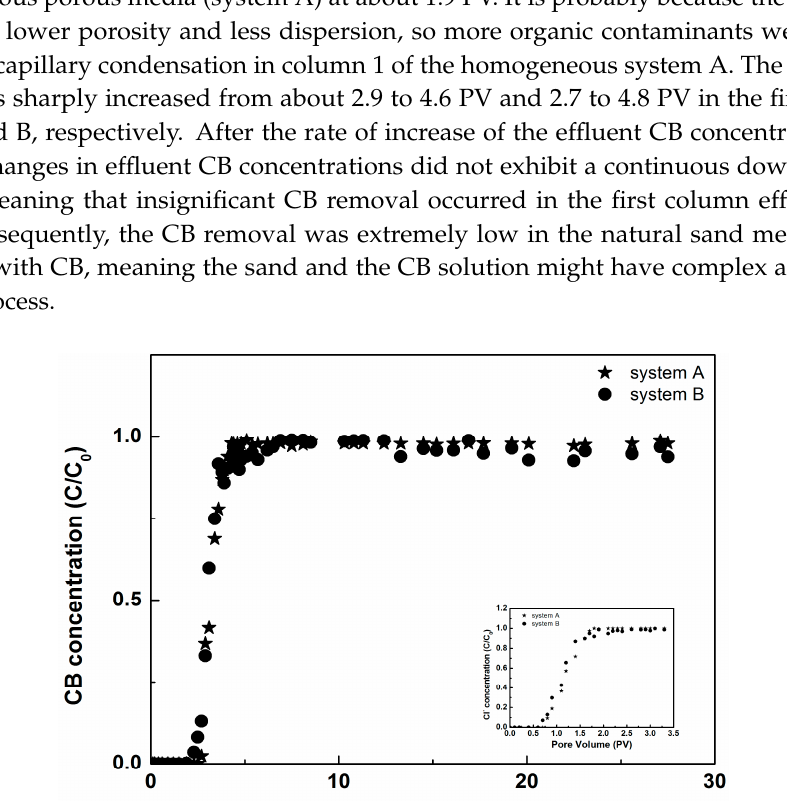
Figure 6. Variations in CB concentration profiles over times for column two of both systems. The inset displays the breakthrough curve of a sodium chloride (NaCl) tracer. 3.3. Released Iron Ion Concentration in Effluents Iron ions are an important form of iron in aqueous environments. Hence, monitoring the variations in the iron ion concentrations in the effluents of the second columns of systems A and B was important during the treatment. The results shown in Figures 7 and 8 demonstrate that the iron ion concentrations in the effluent of both systems was initially almost undetectable, gradually increasing to maximum values of 8.722 and 9.479 mg/L at about 13.3 and 7.5 PV for systems A and B, respectively, because iron ions formed during the electrolysis process and were released from the PRB reaction zone into the solution. The maximum iron concentration in system B occurred later than in the homogeneous system but the maximum was higher than that of system A. With the longer treatment time, the effluent Fe concentration decreased drastically with very low levels observed by the end of the entire treatment, the consumed iron ions might be used for the activation of degradation process. At the last period, iron ions reacted with OH − to form precipitations, inducing the decrease of iron ions concentrations in the solution. By the end of the treatment, the iron ions concentrations were 0.093 and 0.059 mg/L for systems A and B, respectively, which meet the quality standard for groundwater (GB/T 14848-93, China) [43].